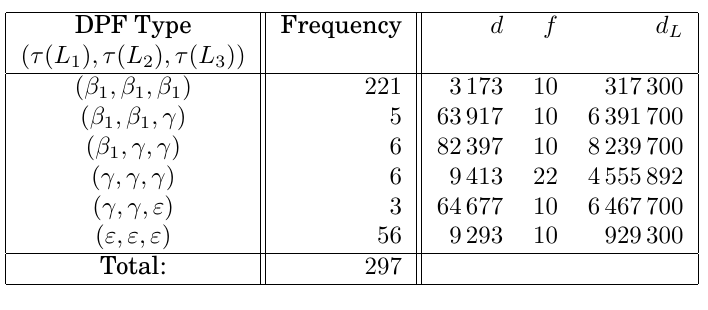
Table 26: Types of triplets with two non-split ramified